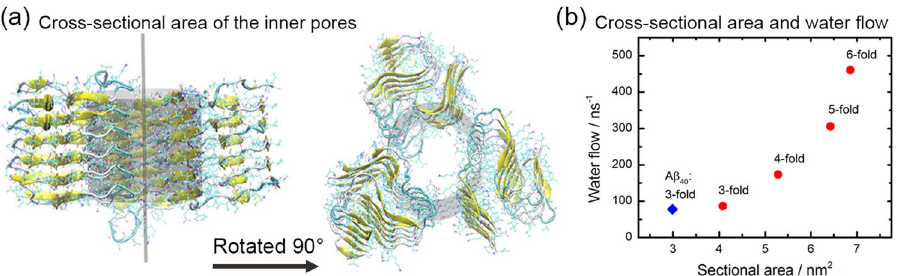
Figure 9. Pores and water flow. ( a ) Cross-sectional area of the inner pores in our N-fold models. ( b ) The cross- sectional area of pores and water flow in our N-fold fibril models.